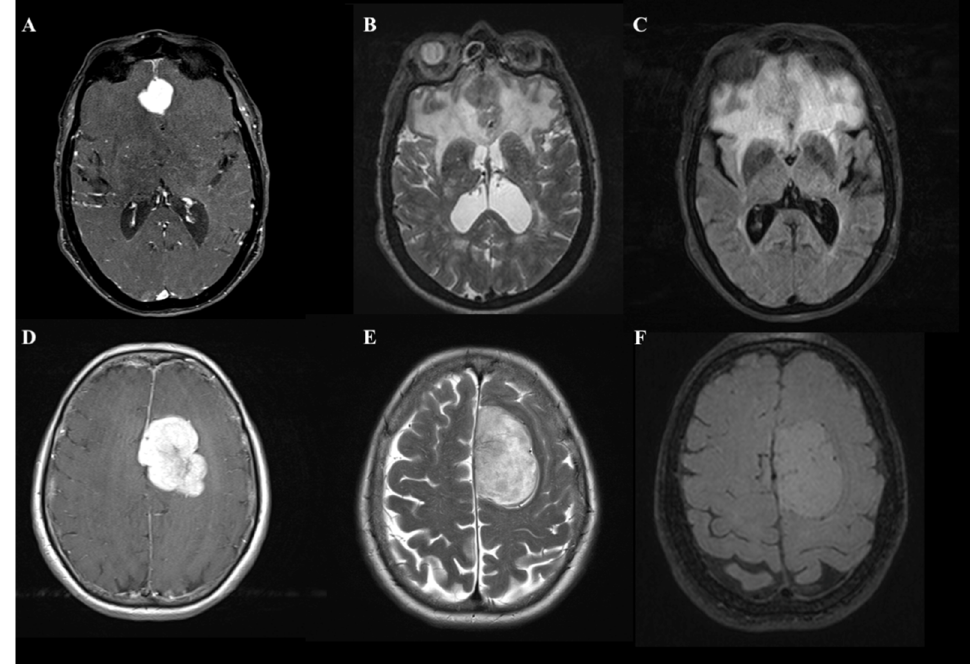
Figure 1. A comparison of two cases of patients with frontal lobe meningioma with an asymptomatic onset that, on MRI images, document entirely different volumes of edema. In the first case, T1 ‐ weighted with MDC ( A ), T2 ‐ weighted ( B ), and FLAIR ( C ) images show a 2 cm para-alpine lesion with edema involving the entire frontal lobe. In the second case, the identical sequences ( D – F ) show a more than 4.5 cm lesion in diameter with a volume of edema almost absent.